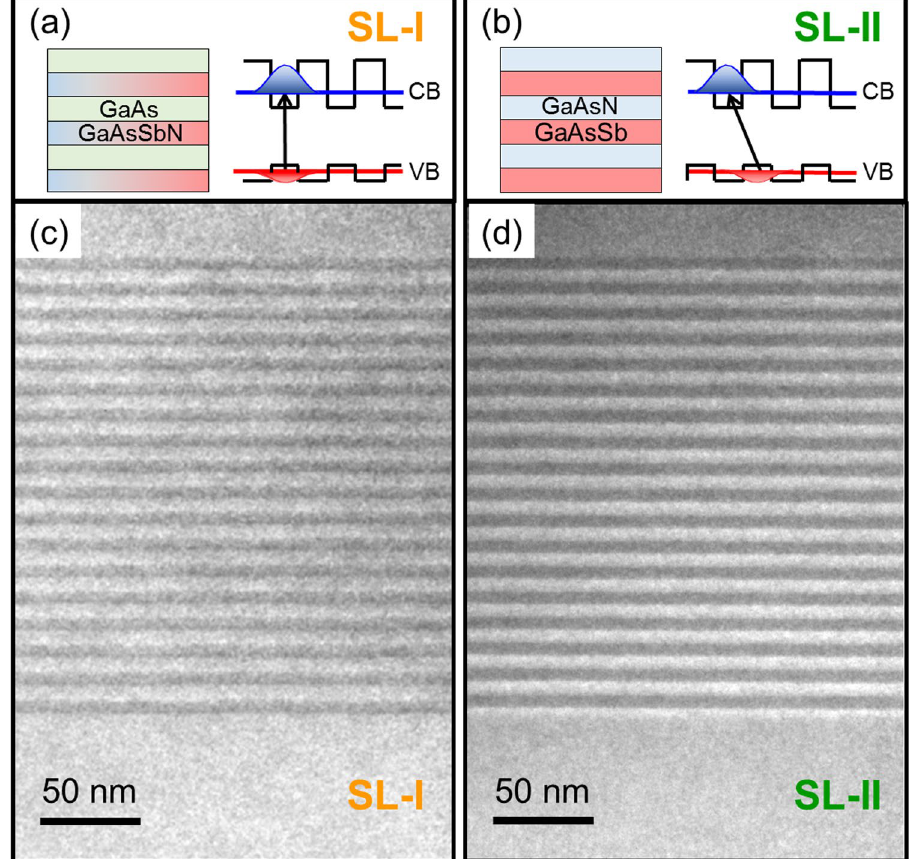
Figure 1. Epitaxial and band structure of 12 nm period SL structures. ( a , b ) Sketch of the epitaxial layout and expected band structure (not to scale) of samples ( a ) SL-I (GaAsSbN/GaAs SL) and ( b ) SL-II (GaAsSb/GaAsN SL). A type-I band alignment is expected in sample SL-I , with the maximum of the distribution probability of electron and hole wavefunctions (in blue and red, respectively) localized in the GaAsSbN layer. A type-II band alignment is expected in sample SL-II , with the maximum of the distribution probability of the electron and hole wavefunctions localized in the GaAsN and GaAsSb layers, respectively. ( c,d ) Dark field 002 TEM images of the same two samples showing the SL structure embedded in GaAs. ( c ) SL-I : the darker layers correspond to GaAsSbN, while the GaAs layers in the SL show the same contrast than in the buffer and capping layers. ( d ) SL- II : the darker layers corresponds to GaAsN whereas the brighter ones are